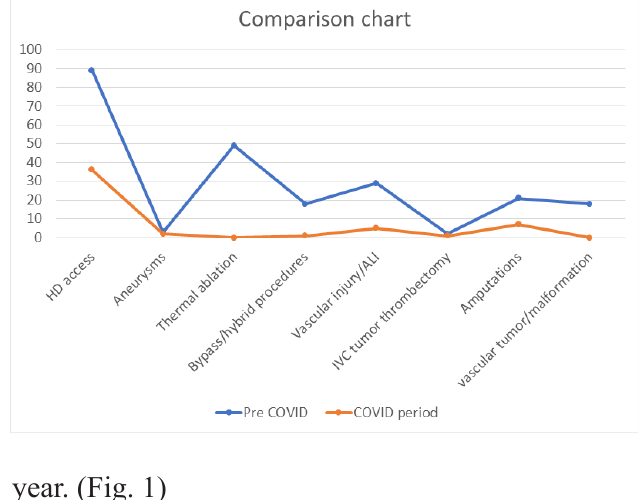
Fig. 1 Comparison of Vascular Surgeries in the two